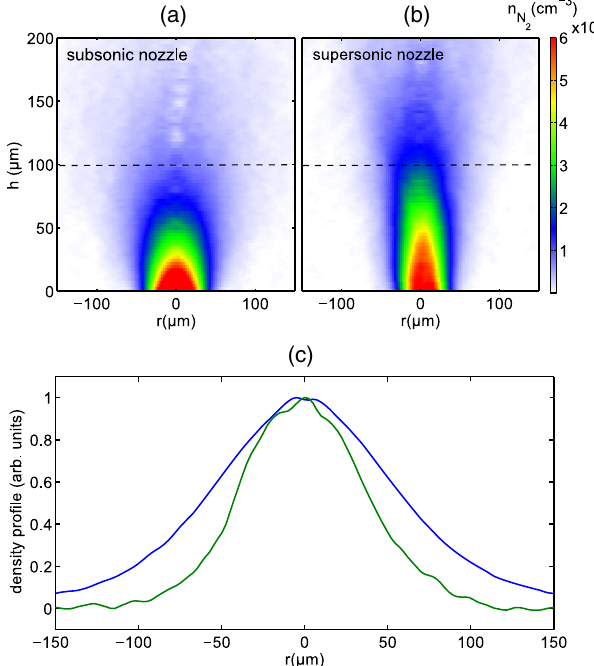
ð r; h Þ (a) for the subsonic FIG. 2. Molecular density map n N 2 nozzle with backing pressure P ¼ 12 bar and (b) for the supersonic nozzle, with backing pressure P ¼ 60 bar. Both cases lead to similar background pressure in the vacuum chamber but ¼ 1 . 8 × 10 19 cm − 3 for the the peak density at h ¼ 100 μ m is n N 2 ¼ 8 × 10 18 cm − 3 for the subsonic nozzle. supersonic jet and n N 2 (c) Normalized density profiles obtained at height h ¼ 100 μ m [dashed line in (a) and (b)]. The 1 =e width is 51 μ m ( 80 μ m) for the supersonic (subsonic)